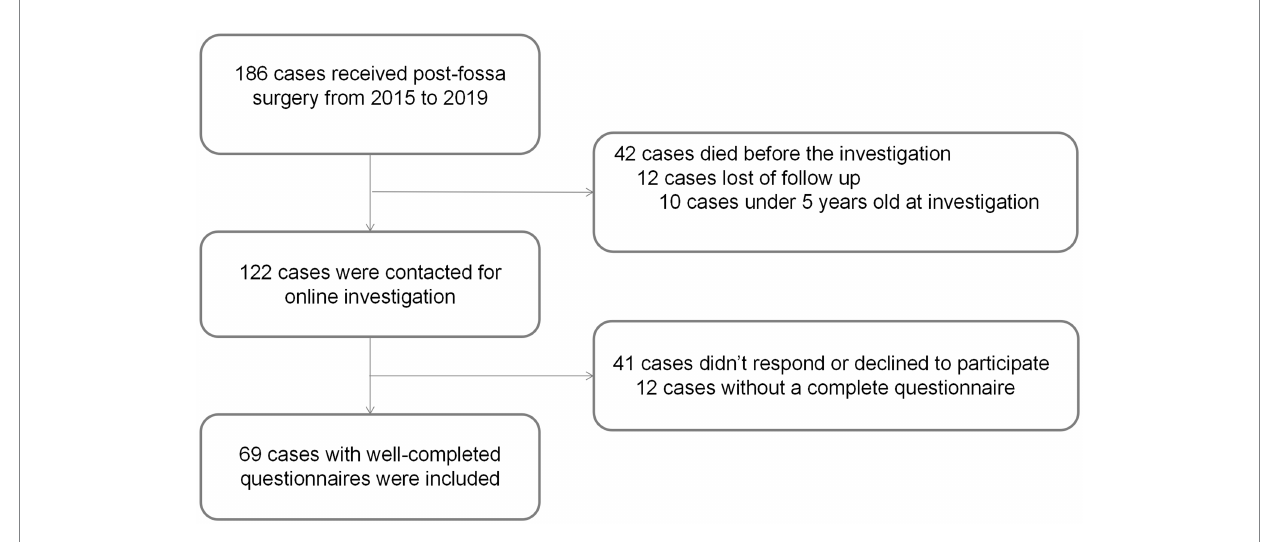
FIGURE 1 Workflow of the patient